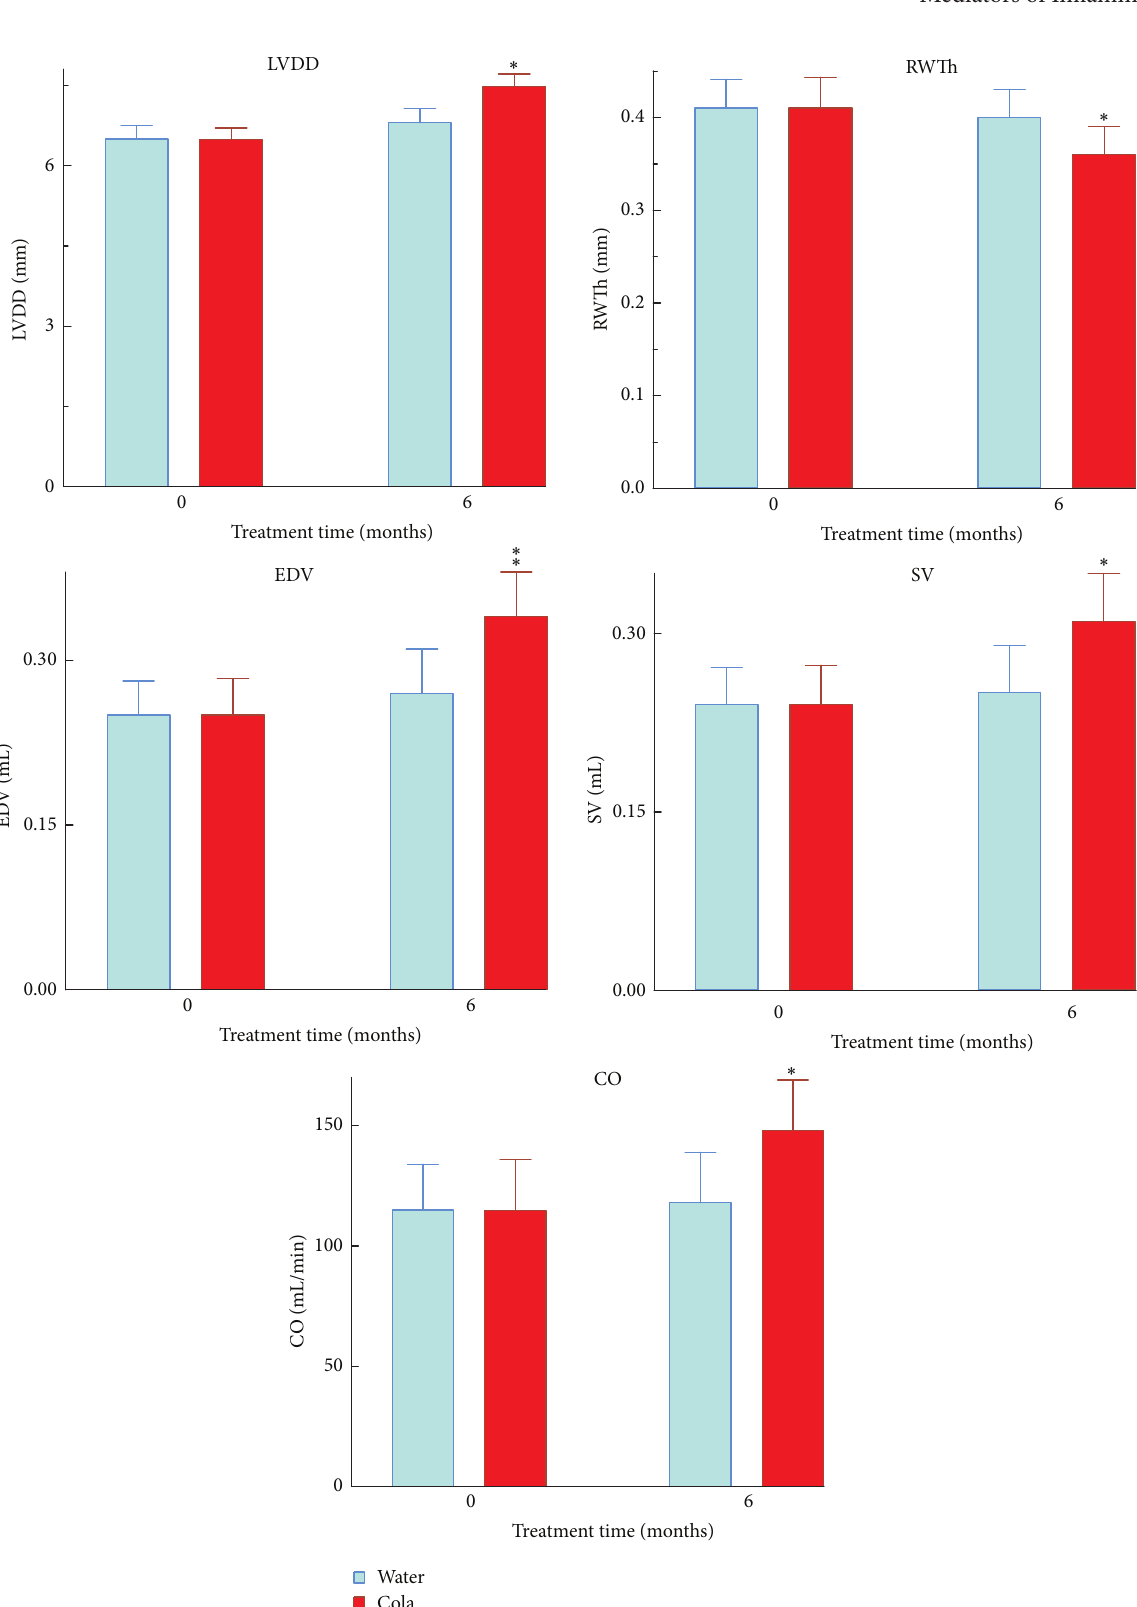
Figure 3: Echocardiographic parameters in rats before and after cola treatment. LVDD: left ventricle diastolic diameter, SV: stroke volume, RWTh: relative posterior wall thickness of LV, EDV: end diastolic volume, CO: cardiac output, and SBP: systolic blood pressure. ∗ 𝑝 < 0.05 and ∗∗ 𝑝 < 0.01 compared with